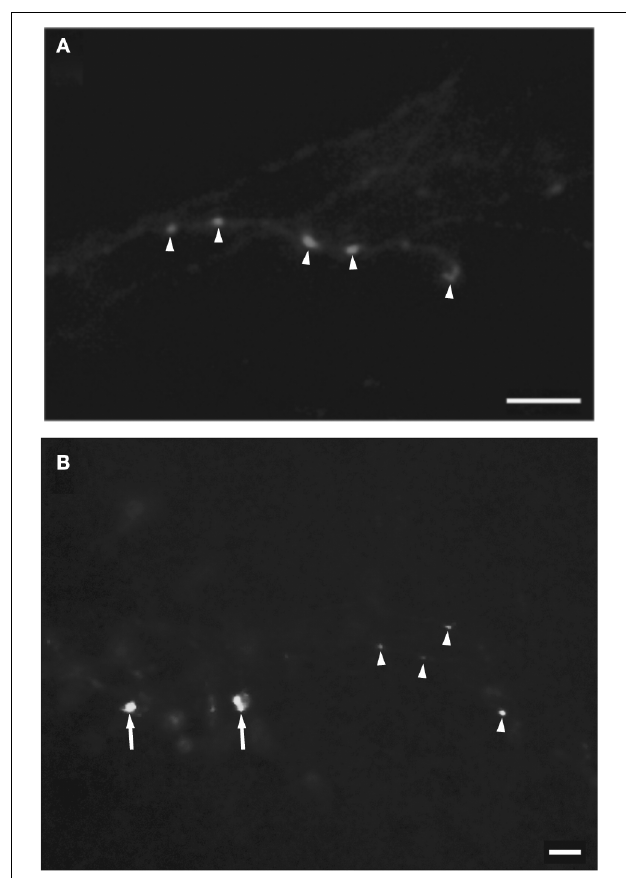
FIGURE 4 | Representative examples of the morphology of target- specifi c retinal terminal fi elds from the contralateral eye seen in the medial portion of the inferior pulvinar nucleus (PIm) (A) and LGN (K1 layer) (B) of the left hemisphere. Retinal terminal fi elds seen in the PIm have thin axons with small sized varicosities (arrow heads) resembling beads on a string. In the K1 layer of the LGN the terminal fi elds are seen to have thick axons with large varicosities (arrows) as well as medium caliber axons with well-spaced medium varicosities (arrow heads). Scale bar = 5 µm in (A) and scale bar = 10 µm in (B)